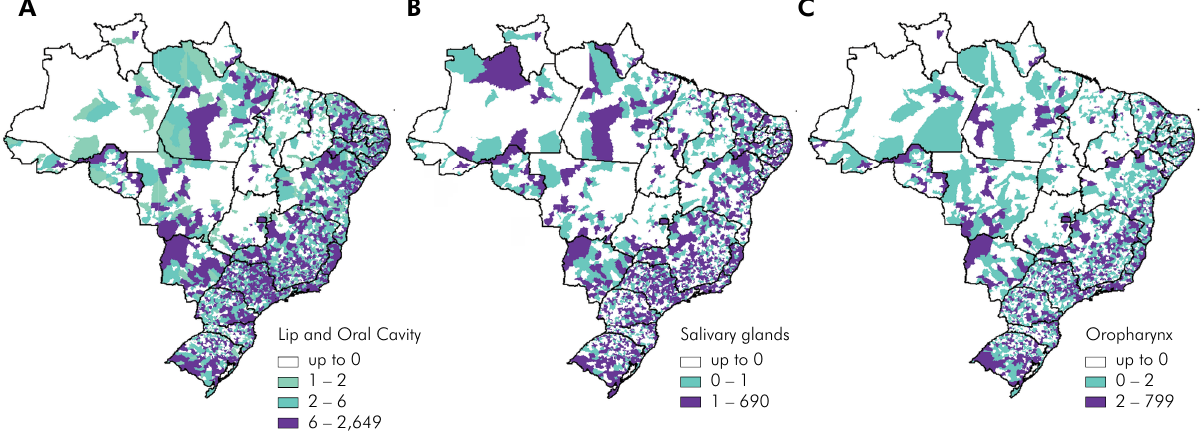
Figure 2. Frequency distribution into quartiles of hospitalized patients with cancer in the lip and oral cavity (A), salivary glands (B) and oropharynx (C) among Brazilian